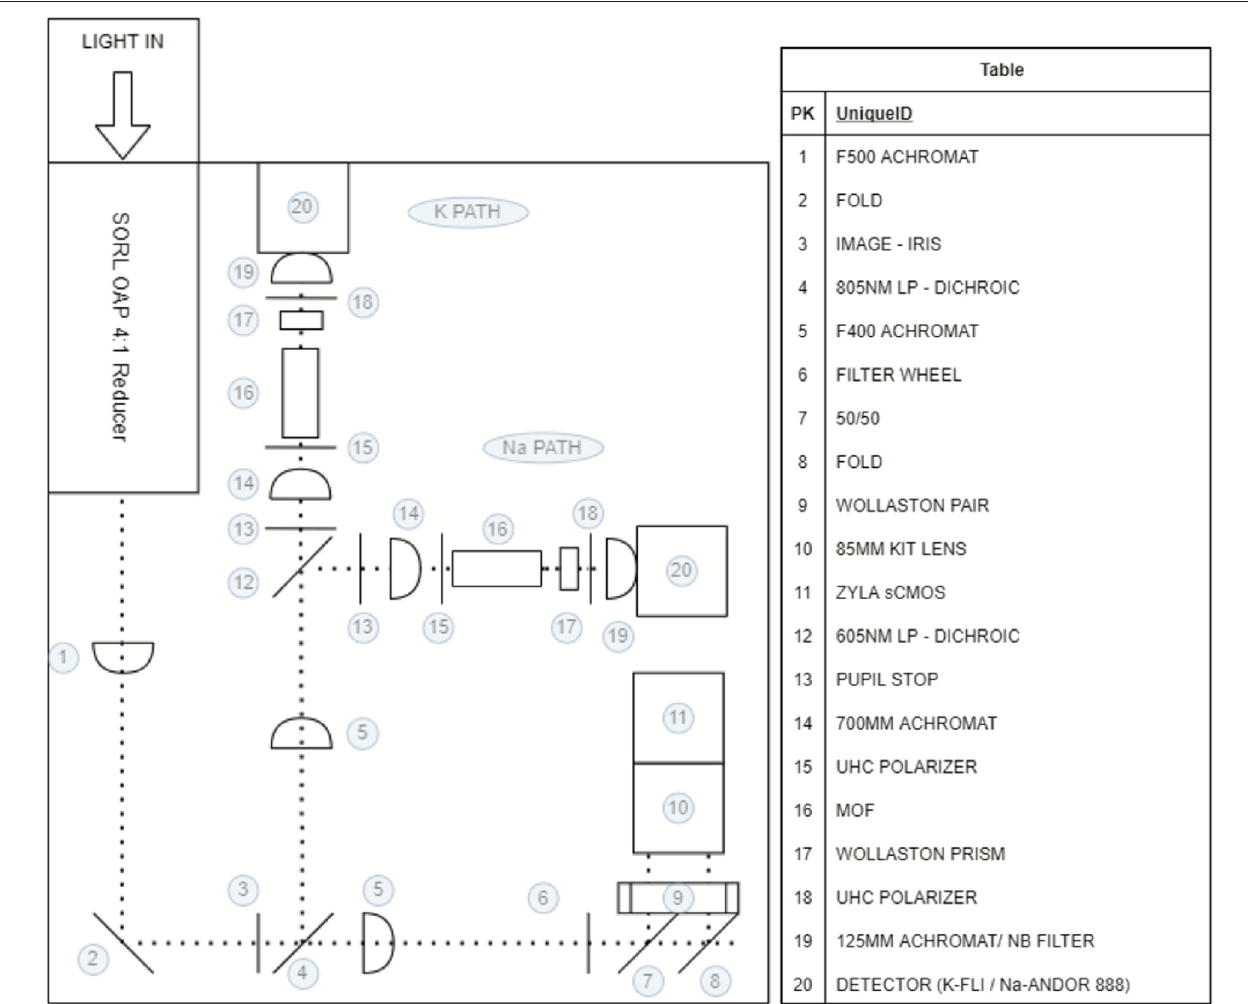
FIGURE 5 | Diagram of the optical bench for the summer 2020 PMODE observational campaign. The left panel displays a top-down view of the bench. The right paneldisplaysthenameofeachopticalcomponentcorrespondingtothenumberedcirclewithintheleftpanel.Thelightentersthroughtheupperleftofthediagram,then is split by dichroics into three separate paths. Clockwise from the top left: 770 nm potassium MOF channel, the 589 nm sodium MOF channel, and fi nally the 889 nm polarimeter channel follows the path along the bottom edge of the diagram.